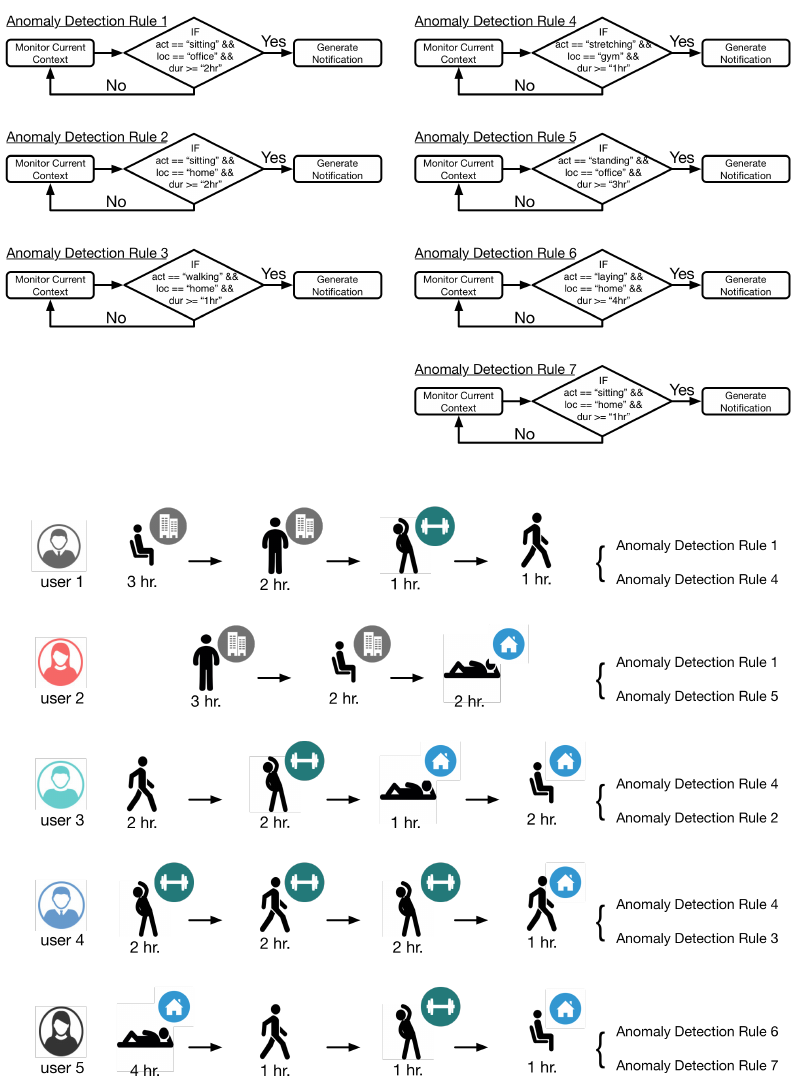
Figure 11. Anomaly detection rules and